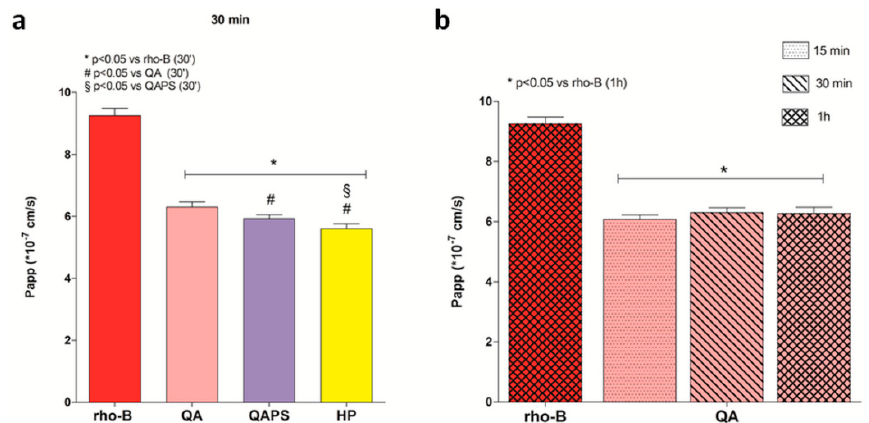
Figure 6. Evaluation of transepithelial permeability of RBITC-HP, RBITC-QA and RBITC-QAPS in CACO-2 cell monolayers. ( a ) The apparent permeability (P app ) values at 30 min. * p < 0.05 vs. rho-B; # p < 0.05 vs. RBITC-QA; § p < 0.05 vs. RBITC-QAPS (ANOVA test). ( b ) The apparent permeability (P app ) of RBITC-QA at 15, 30 and 60 min. * p < 0.05 vs rho-B (ANOVA test). Data are reported as mean ± SD ( n = 3).